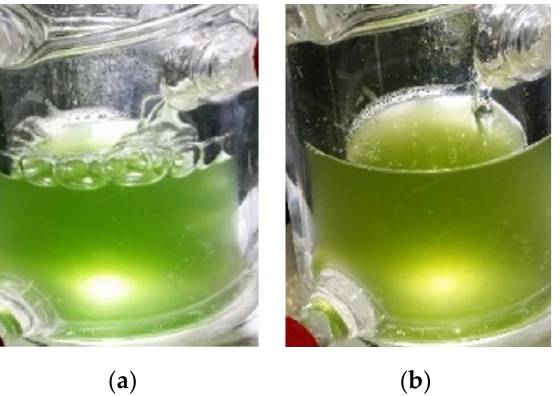
Figure 4. Bacteria dispersion in the buffer solution before ( a ) and after 5 h of irradiation with 20 mW cm −2 UV-light ( b ). The brownish color tone indicates the photodegradation of the bacteria.